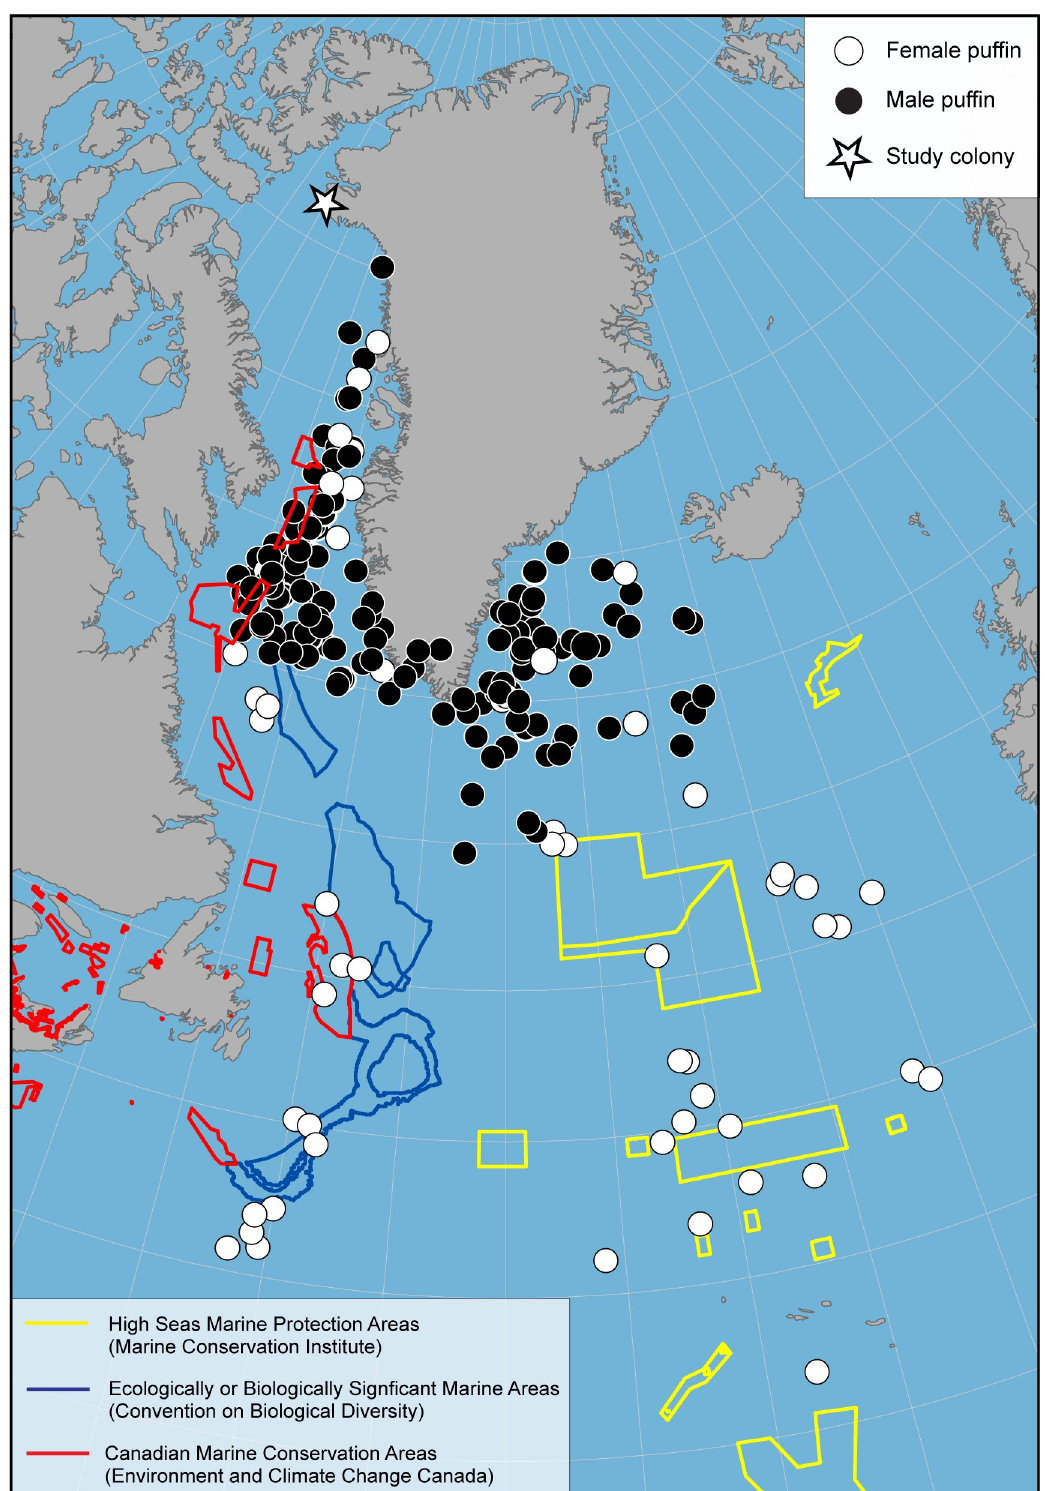
Fig 5. Puffin use of marine conservation areas. Tri-monthly median locations of Atlantic Puffins from northwest Greenland and marine conservation areas (of varying degrees of protection) in the North Atlantic [84–88].Country boundaries from [28].